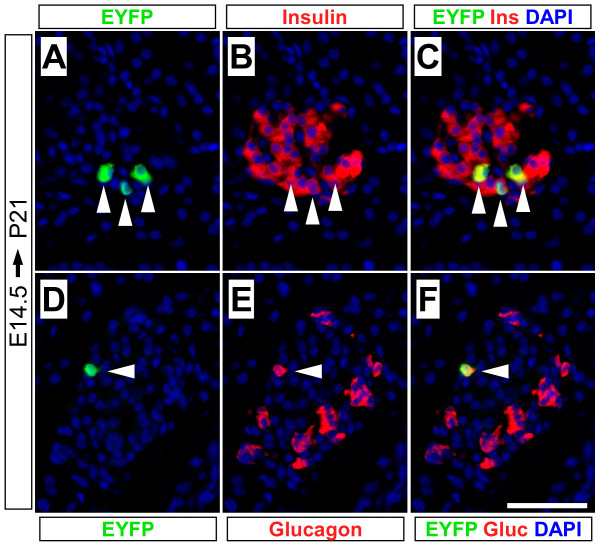
Postnatal islet cells derive from embryonic Muc1+ progenitors. Muc1IC2/IC2; Rosa26EYFP/+ mice received tamoxifen in utero (5 mg to pregnant dam at E14.5), and were analyzed at P21 by immunofluorescence for EYFP lineage label (green), insulin (A-C, red) and glucagon (D-F, red). After inducing the Muc1 lineage at E14.5 and chasing offspring until P21, EYFP labeling (white arrowheads) is detected among both insulin+ β-cells (2.2 +/- 0.4%) and glucagon+ α-cells (2.1 +/- 0.2%). Scale bar: 50 μm.